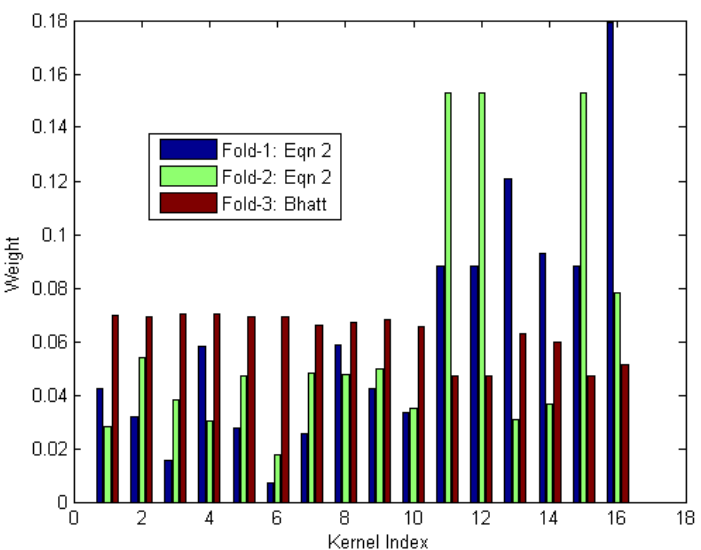
Figure 3. Bar plot showing the highest performing weight assignments for each Fold. Specifically, for Fold-1 and Fold-2, DiMKL 2 was the best performer, and for Fold-3, DiMKL 5 . Finally, we see evidence validating that each iECO individual brings unique and useful information as the weight assignments are nearly